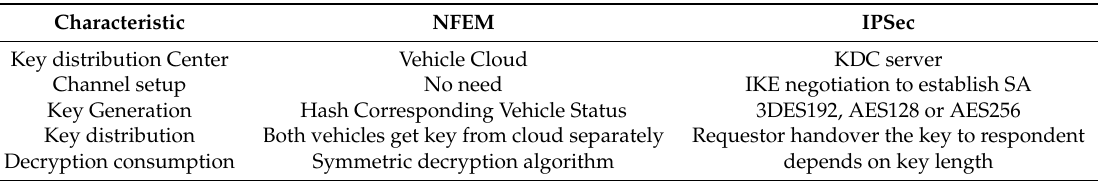
Table 2. Algorithm comparison.